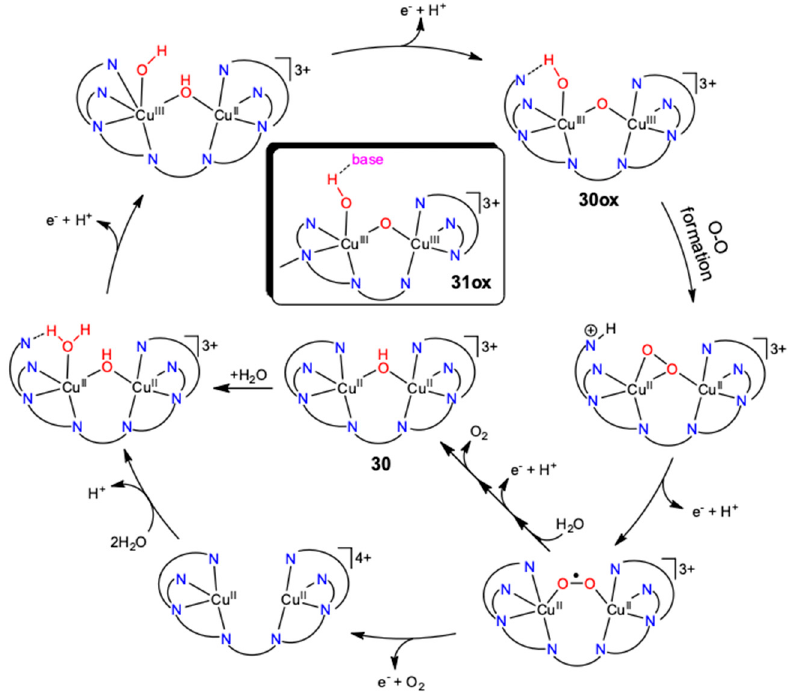
Figure 20. Proposed mechanism for 30 [65] highlighting the main difference to 31 .